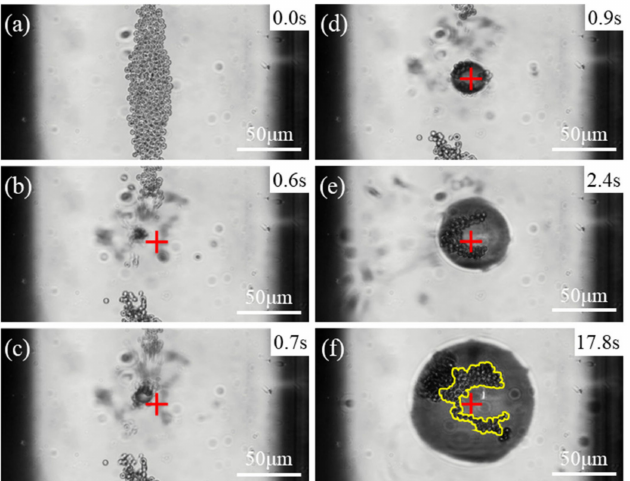
Figure 2. Microbubble generation and growth in a capillary tube with diameter of 0.2 mm. c = 1.2 × 10 7 cm − 3 . P = 189 mW. “+” indicates the laser focal spot. ( a ) The laser was off and the APs settled at the bottom of the capillary tube. ( b – e ) Laser was on and a microbubble was generated and grew; some APs gathered at the bottom of it. ( f ) The yellow outline marks the APs at the bottom of the microbubble when bubble size is stable and they are